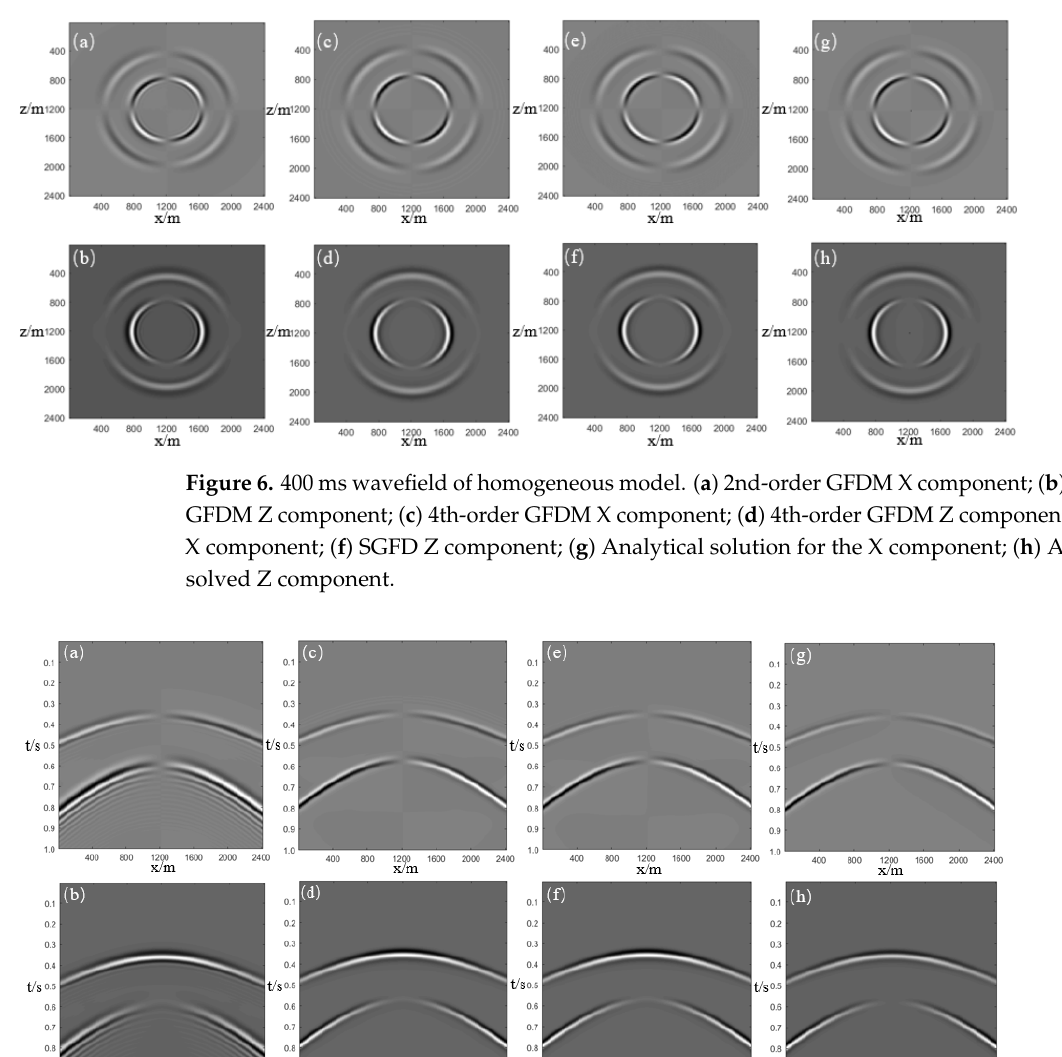
Figure 7. Shot record of homogeneous model, ( a ) 2nd ‐ order GFDM X component; ( b ) 2nd ‐ order GFDM Z component; ( c ) 4th ‐ order GFDM X component;( d ) 4th ‐ order GFDM Z component; ( e ) SGFD X component; ( f ) SGFD Z component;( g ) Analytical solution for the X component; ( h ) Analytically solved Z component.